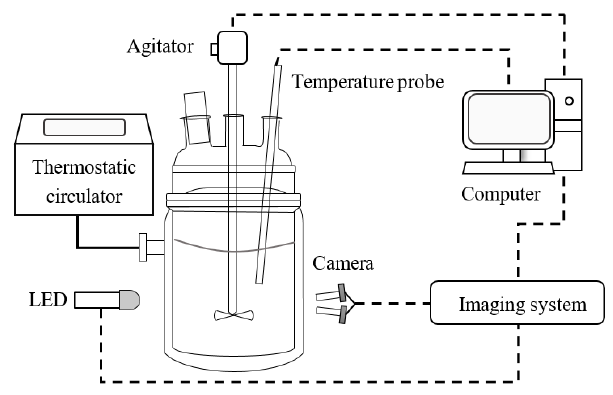
Figure 2. Schematic drawing of the experimental setup.